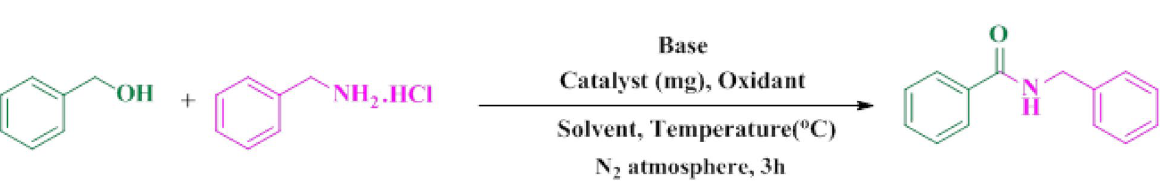
Figure 6. Model reaction to optimize the tandem oxidative amidation of benzylic alcohols by CN-Pr-β-CD/ Cu(II)